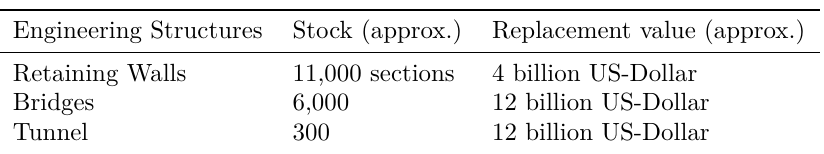
Table 1. Number and replacement value of various SBB engineering structures [3].